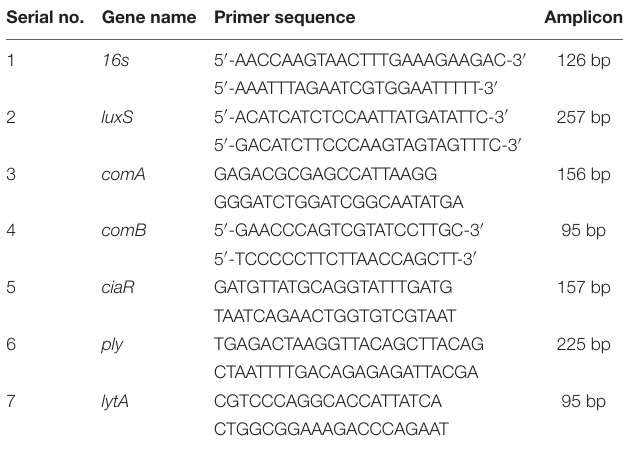
TABLE 1 | List of primers used in real-time RT-PCR gene expression